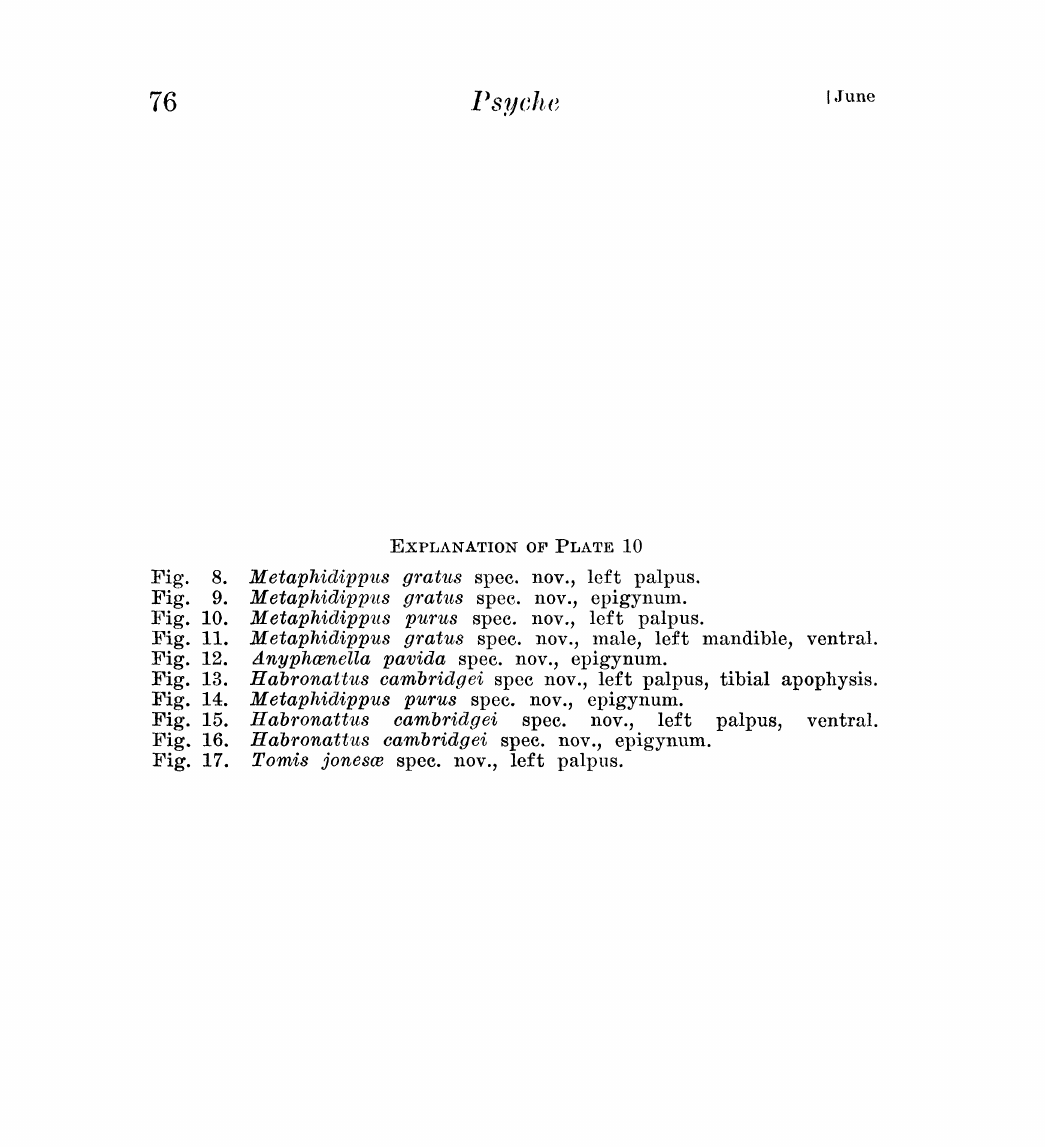
Fig. 8. Metaphidippus gratus spec. nov., left palpus. Fig. 9. Metaphidippus gratus spec. nov., epigynum. Fig. 10. Metaphidippus purus spec. nov., left palpus. Fig. 11. Metaphidippus gratus spec. nov., male, left mundible, ventral. Fig. 12. Anyphcenella pavida spec. nov., epigynum. Fig. 13. Habronattus cambridgei spcc nov., left palpus, tibial apophysis. Fig. 14. Metaphidippus purus spec. nov., epigynum. Fig. 15. Habronattus cambridgei spec. nov., left palpus, ventral. Fig. 16. Habronattus cambridgei spee. nov., epigynum. Fig. 17. Totals jonesce spec. nov., left